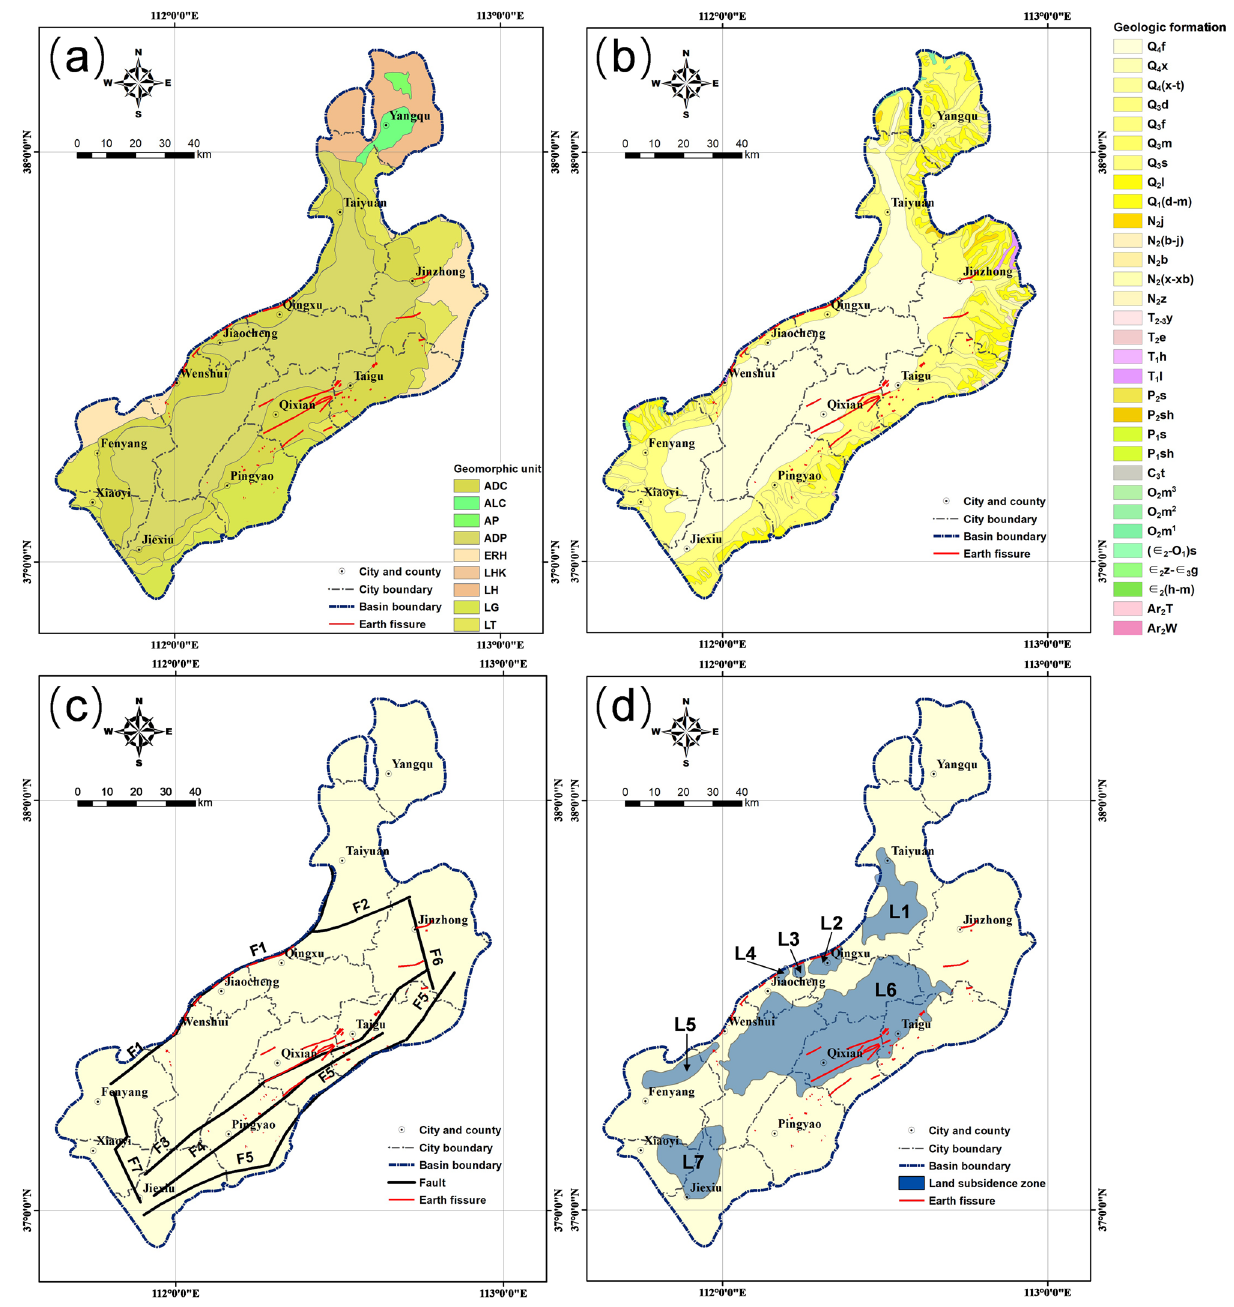
Figure 2. Maps showing ( a ) geomorphic units, ( b ) geologic formations, ( c ) faults, and ( d ) land subsidence zones in the study area. The geomorphic, fault, and land subsidence zone maps are adapted from the Geological Environment Monitoring Center of Shanxi Province, China. The geologic map is adapted from the China Geological Geologic formations were also normalized based on the proportion of the cumulative length of earth fissures to the total length of earth fissures. The proportion of the length of earth fissures within the Fangcun Formation was as high as 51%, which was the maximum proportion among the formations, while the minimum nonzero proportion occurred in the Xuanren-Tuoyang Formation, where the length of earth fissures was 0.2 m. Therefore, the Fangcun Formation was rated as 9, and the corresponding rating of the Xuanren-Tuoyang Formation was 1. Other geologic formations were rated between 1 and 9, as listed in Table 3. It should be noted that twenty-one geologic formations that are scattered at the basin margins (e.g., the Yangchang, Ermaying, and Heshangou for- mations) with no earth fissures were rated as zero. The ratings for each geologic formation are presented in Fig. 3c. Faults were normalized based on the distance to the fault and the activity rate. The Qingxu-Jiaocheng section of Fault F1 had the highest activity rate, reaching 1.3 mm/a, and the latest active age was the middle Holocene